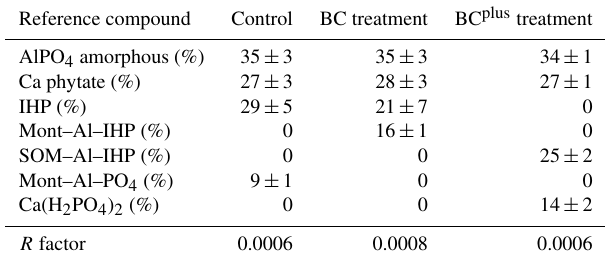
Table 5. Results of linear combination fitting (LCF) conducted on P K -edge XANES spectra of unfertilized (control) and fertilized soils with bone char (BC) and surface-modified bone char (BC plus ) particles under 230 days of ryegrass cultivation in a pot experiment. These best fits were achieved using all possible combinations with 19 spectra of P reference